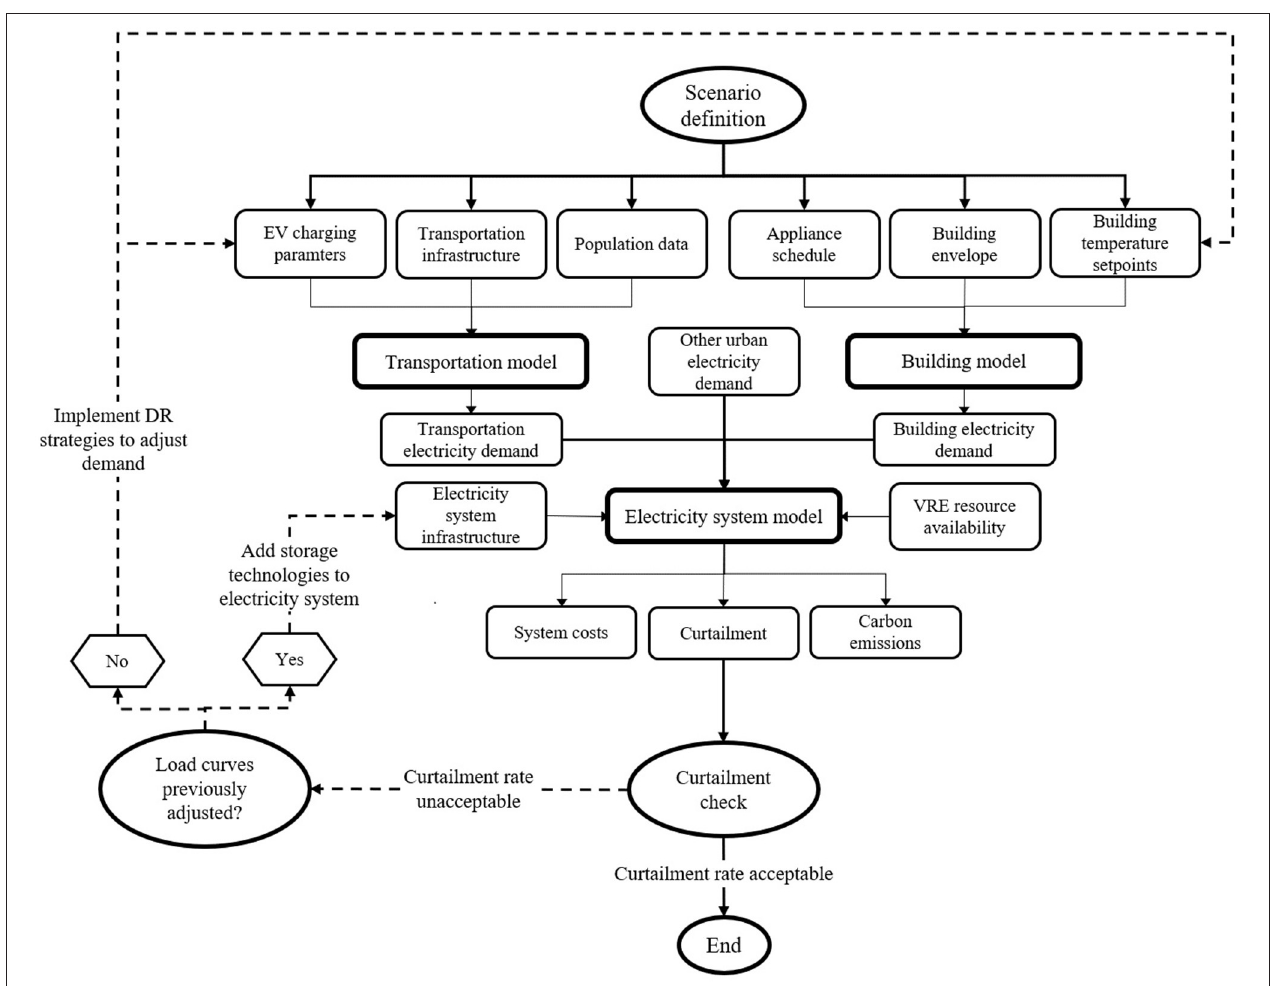
FIGURE 2 | Bidirectional model framework with key inputs and